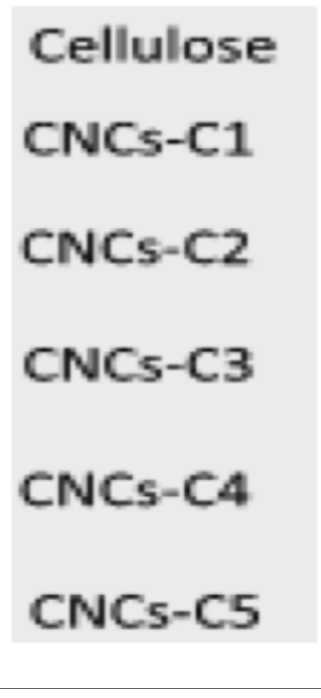
Figure 2. The FT-IR spectrum cellulose and CNCs are hydrolyzed with a reaction time of 1 to 5